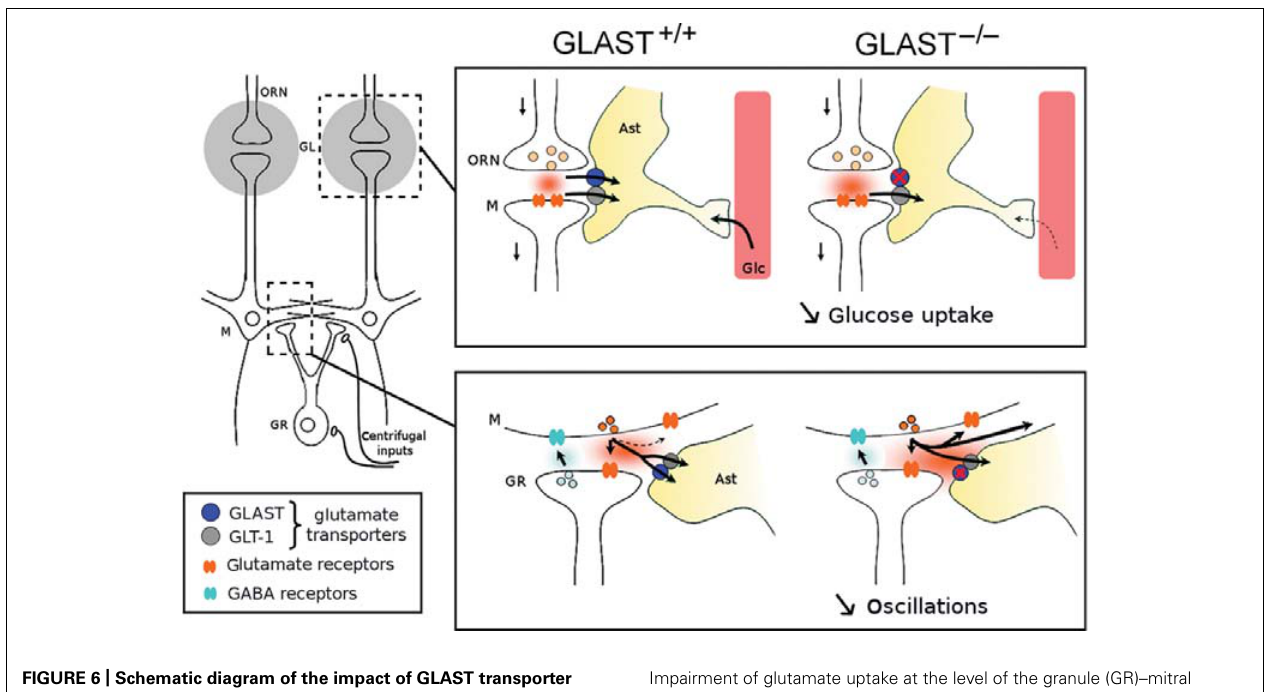
FIGURE 6 | Schematic diagram of the impact of GLAST transporter on olfactory bulb networks. In the GL (upper box), the lack of astrocytic (Ast) glutamate transporter GLAST decreases the uptake of circulating glucose (Glc) during mitral cells (M) activation by glutamate release from the olfactory receptor neurons (ORN).